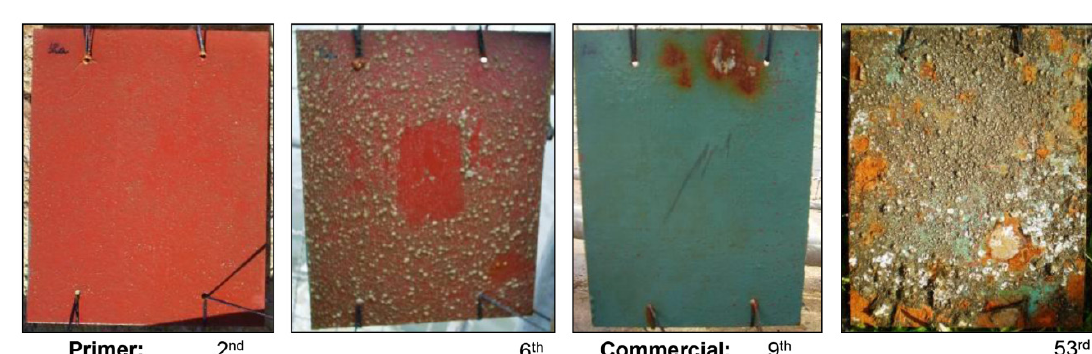
Figure 2. Appearance plates coated with primer and commercial paint, immersed in the marine environment in the weeks.